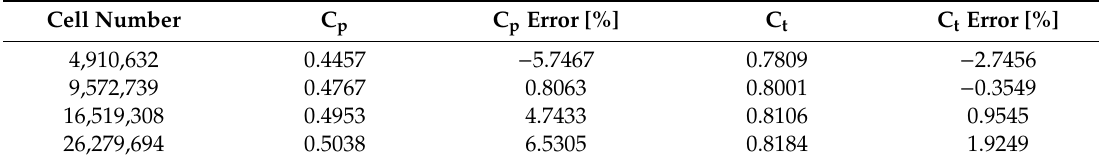
Table 1. The mesh independence test.